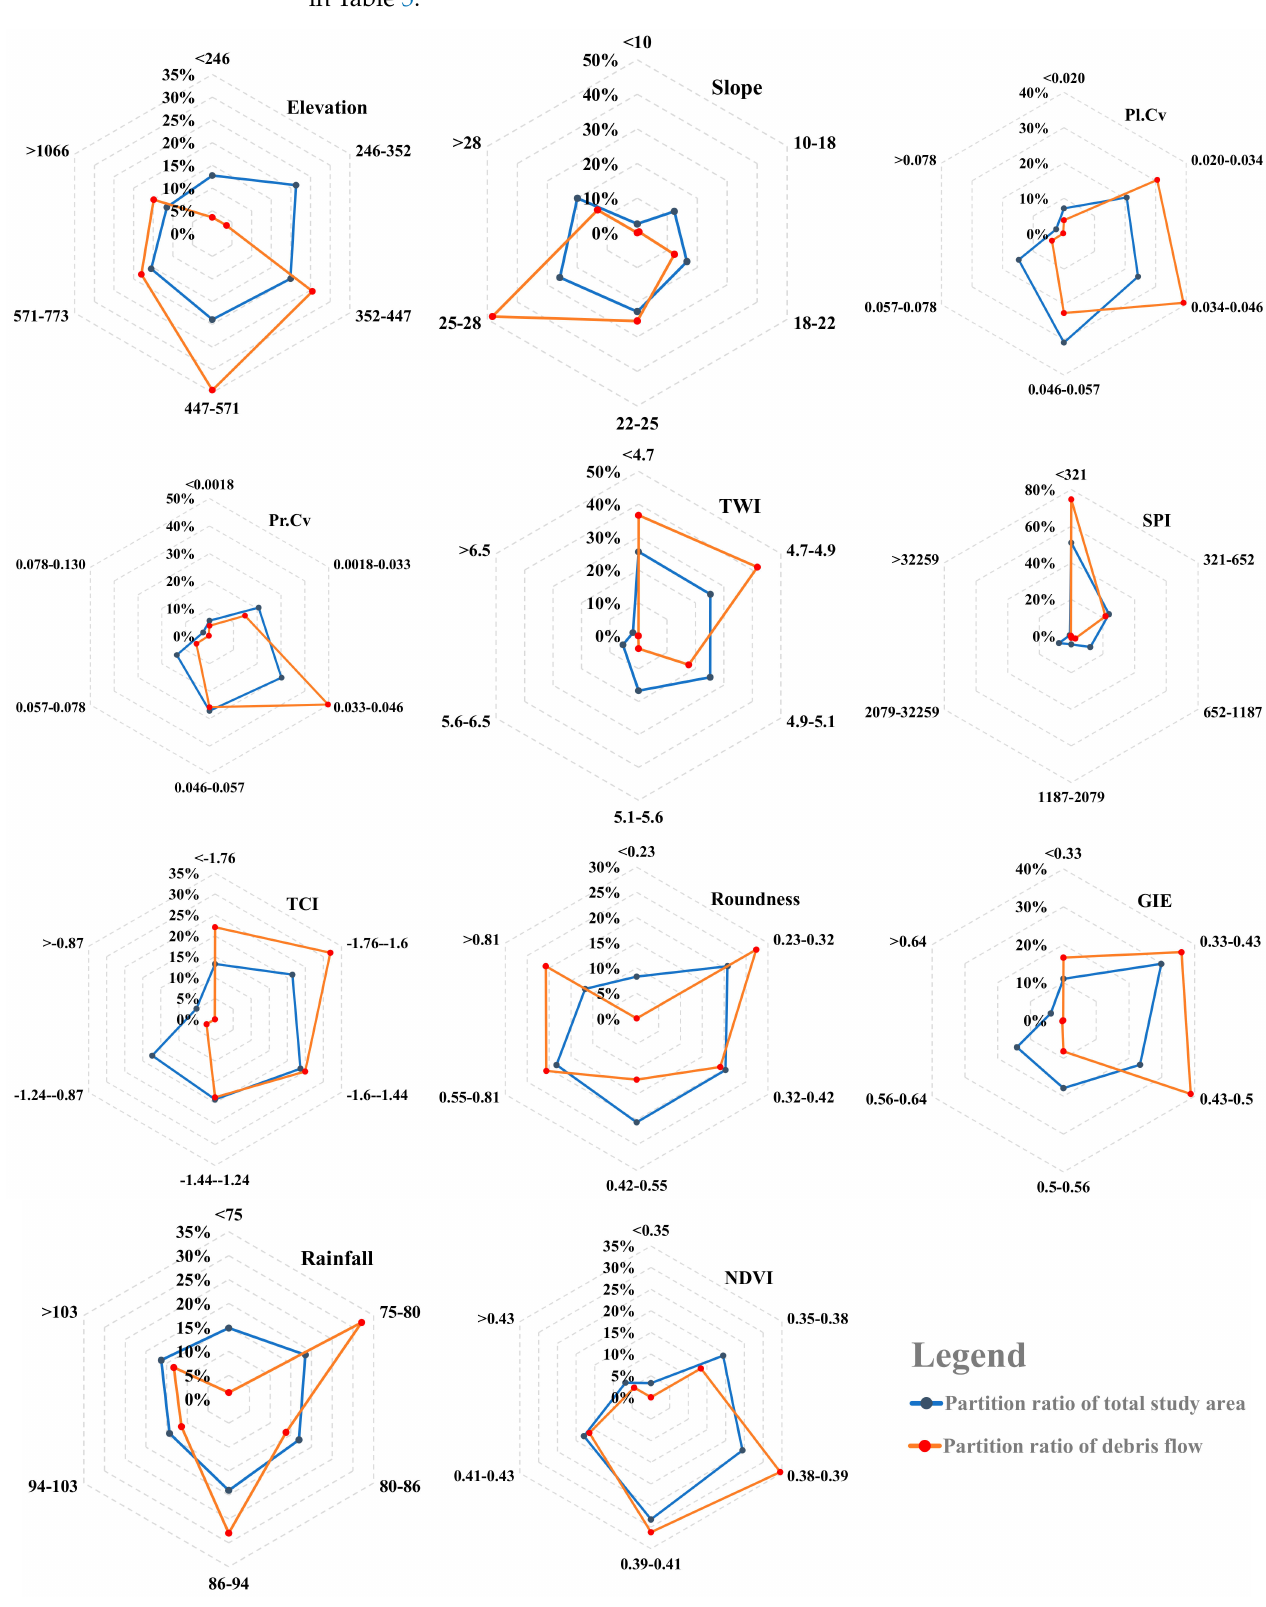
Figure 8. Distribution of debris flow in different classes of